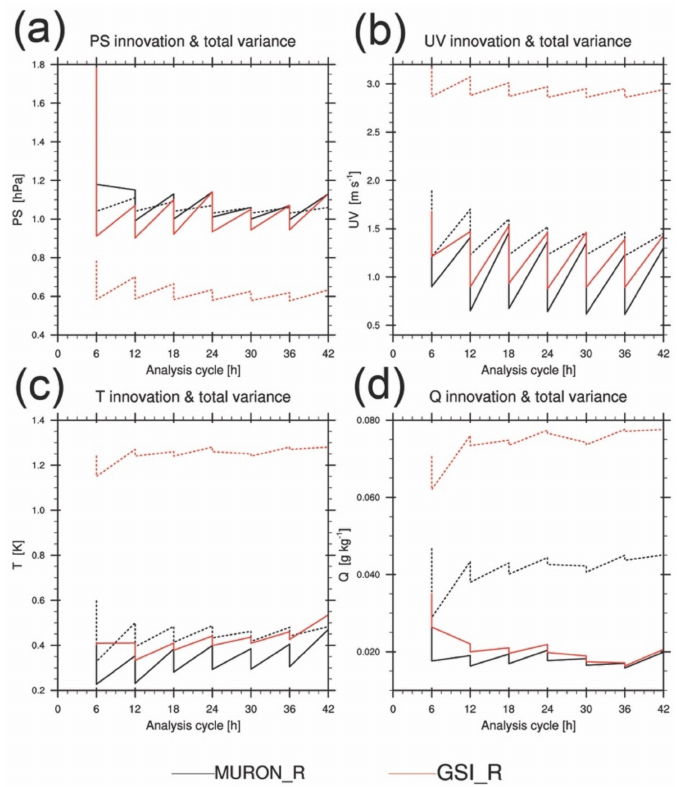
Figure 5. A time series of RMS of innovation (solid line) and total spread (dotted line) for ( a ) surface pressure, ( b ) surface wind, ( c ) surface temperature, ( d ) surface specific humidity for GSI ocean surface observation error (GSI_R) (red line) and modified MURON observation error (MURON_R) (black